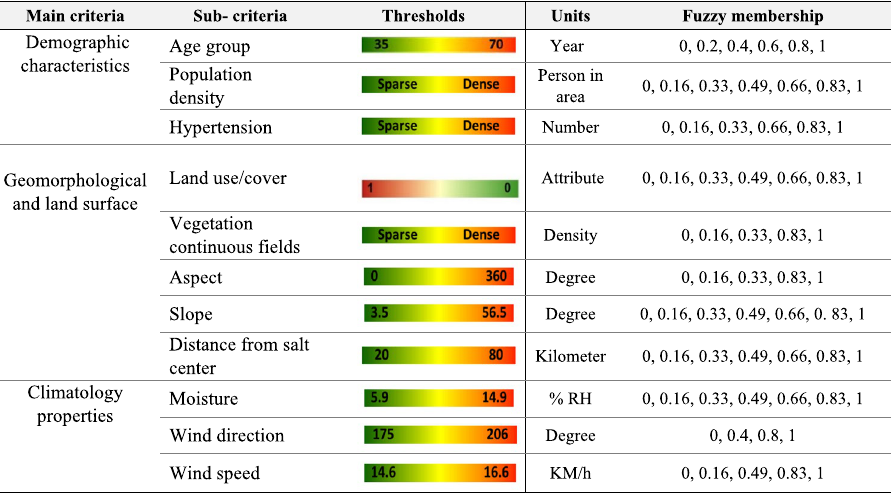
Table 3. The internal classes of each criterion and their fuzzy memberships which are standardized at a scale of 0–1 based on the significance of each criterion for the vulnerability and health